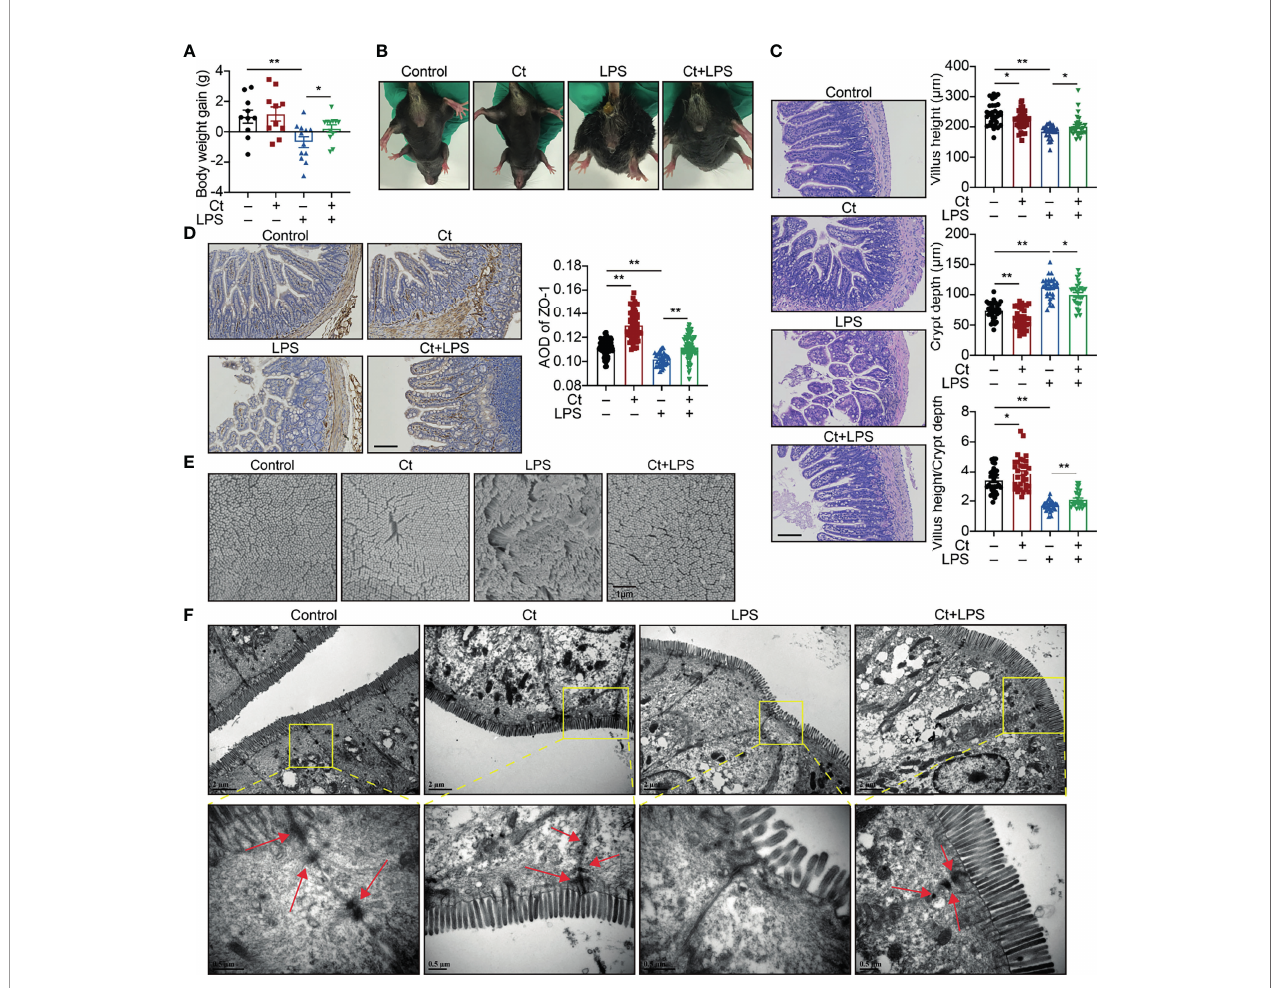
FIGURE 1 | Ct alleviates LPS-induced diarrhea and ileal barrier function in vivo . C57BL/6 were randomly divided into 4 groups, including the Control (n=10), Ct (n=10), LPS (n=12), Ct + LPS (n=12). All samples were collected after 24 h. (A) Body weight gain. (B) Diarrhea. (C, D) H&E staining (C) and ZO-1 expression (D) . The presented fi gures of H&E and ZO-1 staining in each group were from the same sample. Scale bar: 500 m m. (E) Visualization of villus morphology under SEM. Scale bar: 1 m m. (F) Visualization of microvillus and structure of tight junctions under TEM. Scale bar: 2 m m. Data were presented as mean ± SEM. The signi fi cant difference was analyzed by two-way unpaired t-tests. * P < 0.05, ** P <